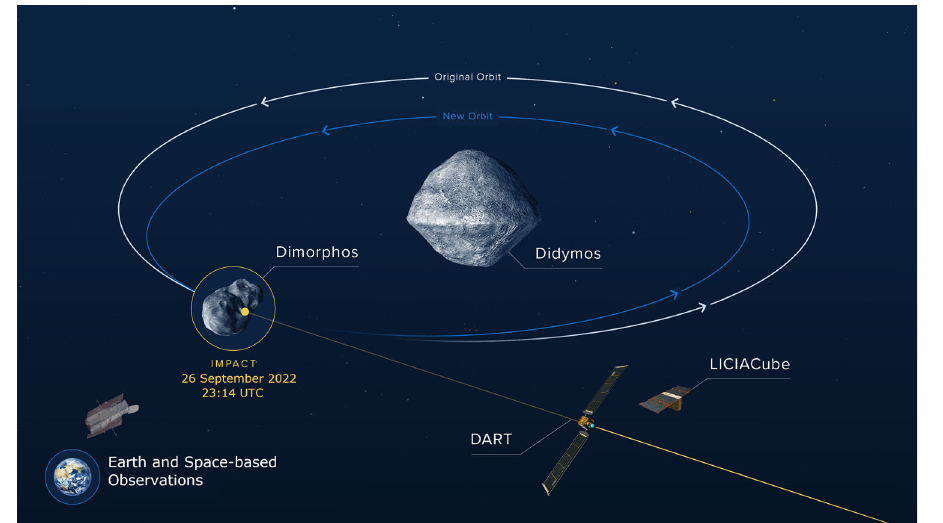
shortened and the mean distance from Dimorphos to Didymos was reduced. Credit: NASA/Johns Hopkins APL, adapted with permission.